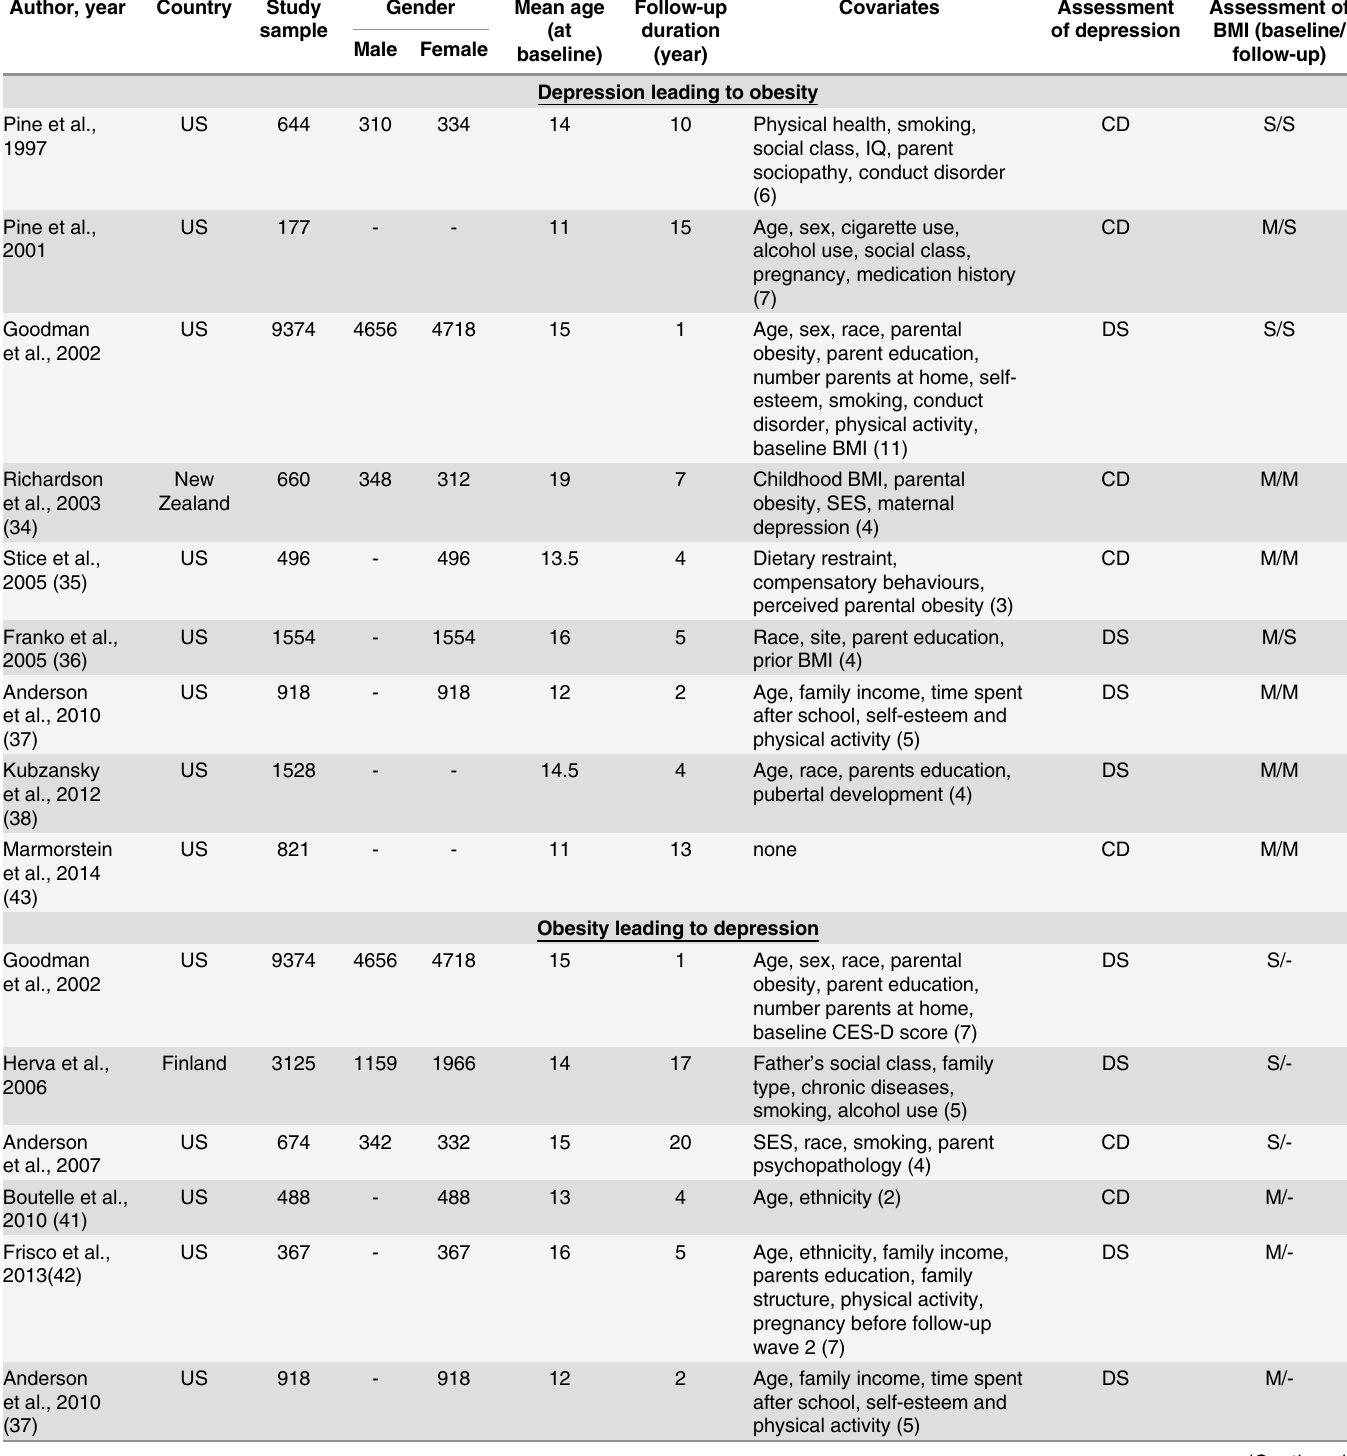
Table 1. Characteristics of the included